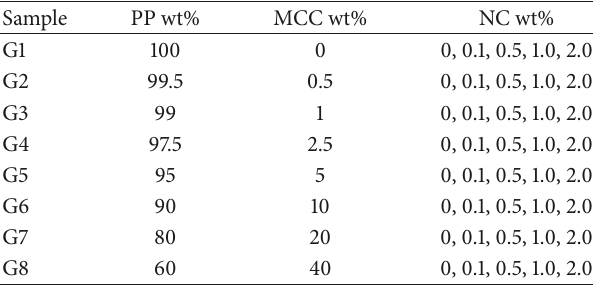
Table 1: Composition of PP/MCC